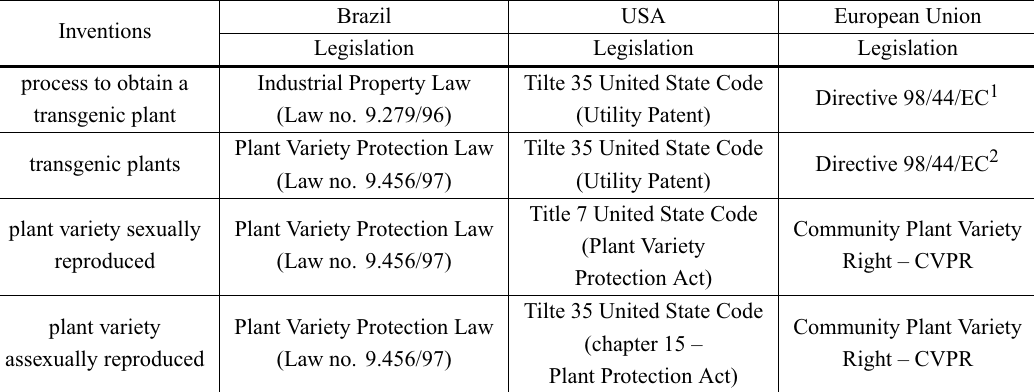
Comparison of the intellectual property protection of some agricultural biotechnology inventions under the Brazillian, the US and the European